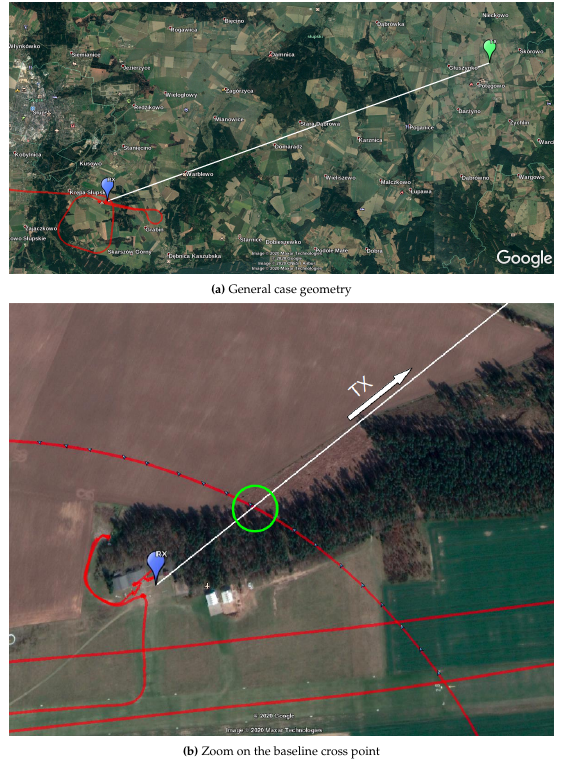
Figure 2. Scenario geometry: transmitter–receiver baseline (white line) cross point marked by a green circle, aircraft trajectory in